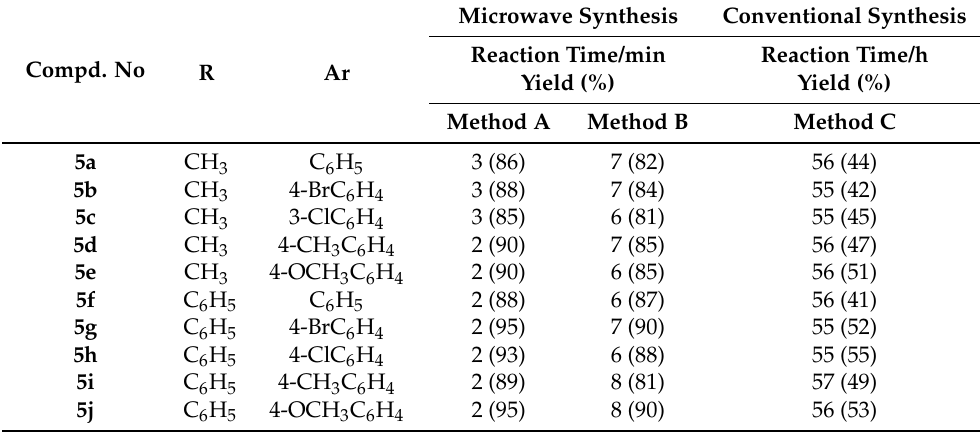
Table 1. Comparison between the microwave and conventional methods in the synthesis of